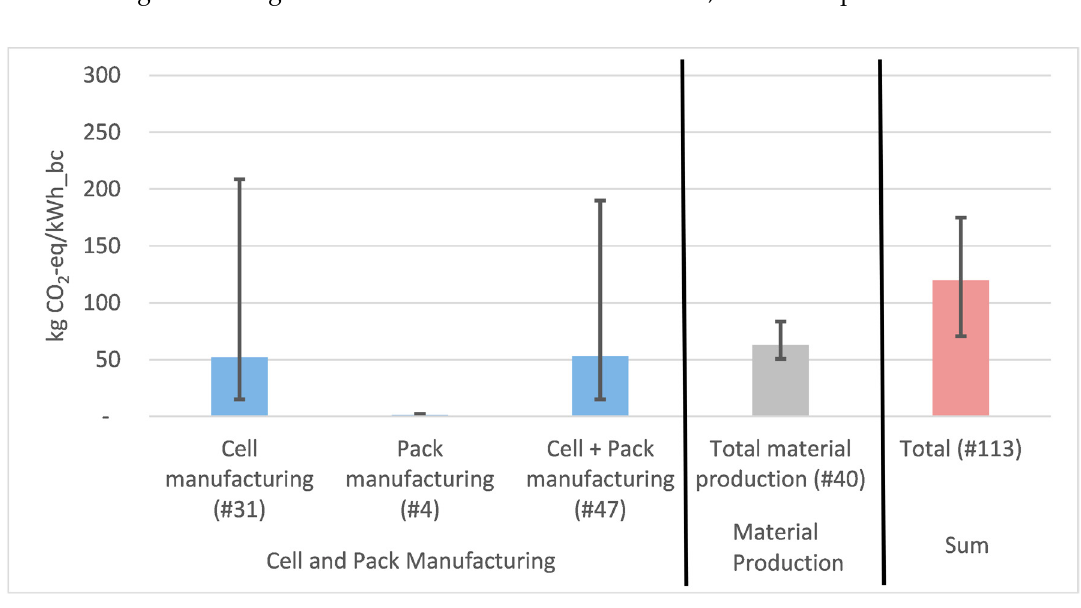
Figure 6. GHG emissions of battery production (results based on median, 25%-quantile, and 75%- quantile).